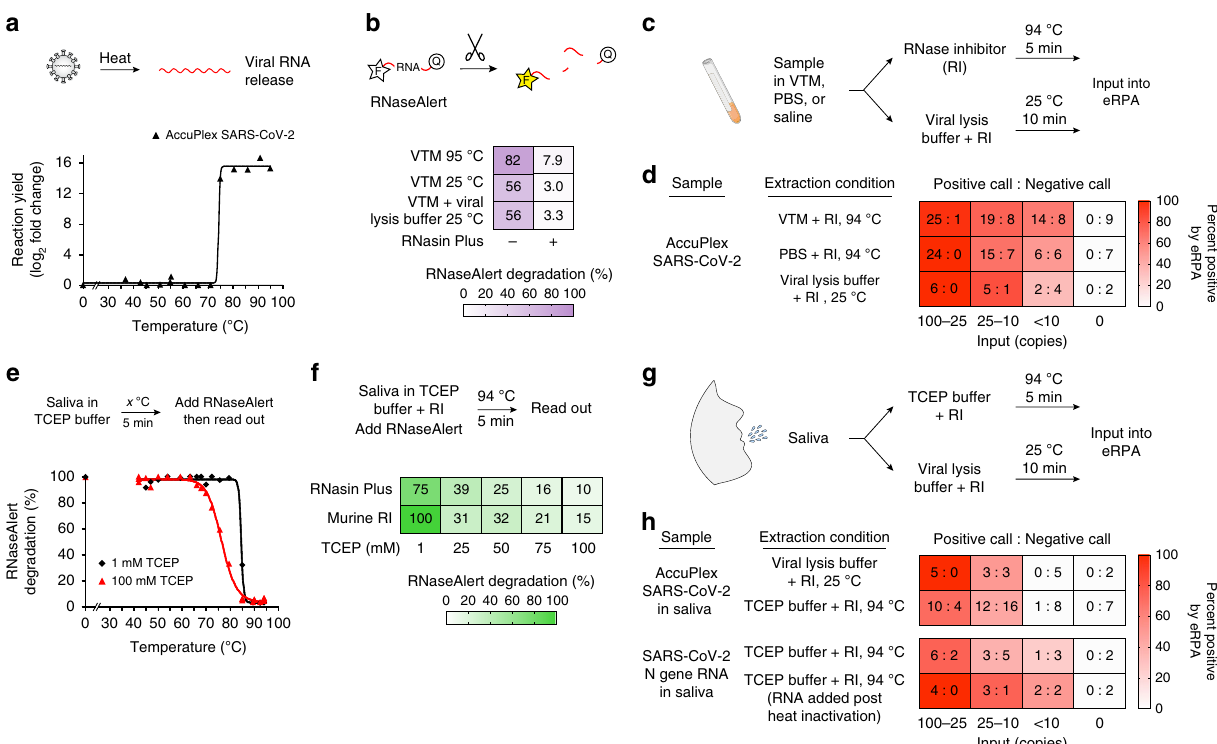
Fig. 3 Lysis and detection of SARS-CoV-2 N gene from contrived samples. a Viral particle temperature lysis determination. AccuPlex packaged SARS- CoV-2 virus was diluted into TCEP buffer and heated for 5 min at the given temperature (see “ Methods ” section). Released RNA was ampli fi ed by eRPA and product formation was quanti fi ed by qPCR. b Detection of RNase activity of VTM. RNaseAlert was added to viral transport media (VTM) with or without the addition of RNasin Plus before heating for 5 min at 94 °C or added to a 1:1 VTM and viral lysis buffer mix and incubating for 10 min at 25 °C. Data represent the average of four technical replicates and were determined by normalizing the fl uorescence intensity 10 min after the heating step to a fully degraded control. c Schematic of sample processing of patient samples in VTM for input into eRPA. d Heatmap displaying eRPA test calls for detection of AccuPlex packaged SARS-CoV-2 lysed with conditions displayed in c . AccuPlex packaged SARS-CoV-2 virus was mixed 1:1 with VTM, PBS, or viral lysis buffer and incubated as shown. All samples included RNasin Plus. Values represent the number of positive test calls: number of negative test calls for each condition. e Inactivation of RNase activity in saliva by TCEP and heat. Saliva was fi rst mixed 1:1 with a buffer containing 1 mM (black diamonds) or 100 mM (red triangles) TCEP and heated at the indicated temperature for 5 min. After cooling, RNaseAlert was added and degradation was assessed as in b . f The combined activities of an RNase inhibitor and TCEP protect RNA from degradation in saliva. RNaseAlert was added to saliva diluted 1:1 with TCEP buffer containing an RNase inhibitor and treated as shown. RNAseAlert degradation was assessed an in b . See additional data in Supplementary Fig. 3g.